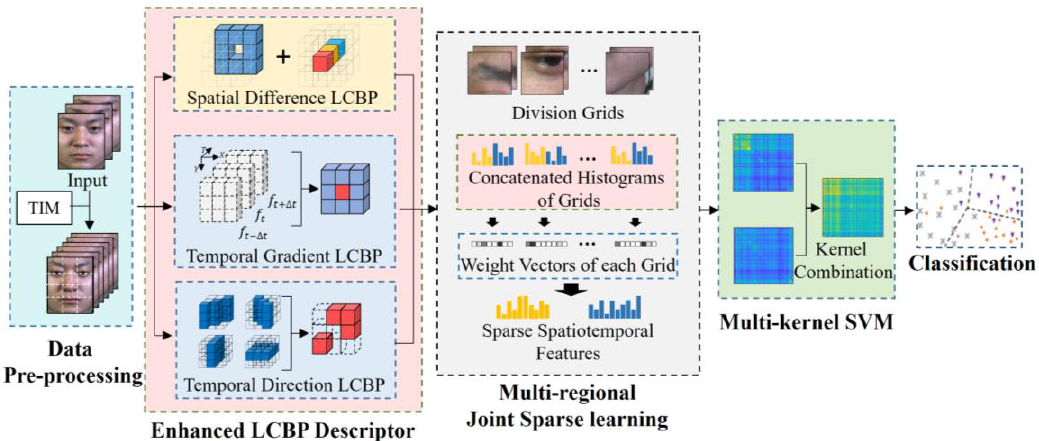
Figure 1. The framework of the proposed method, which mainly includes the Enhanced Local Cube Binary Pattern (LCBP) Descriptor, Multi-Regional Joint Sparse Learning, and Multi-kernel Support Vector Machine (SVM).